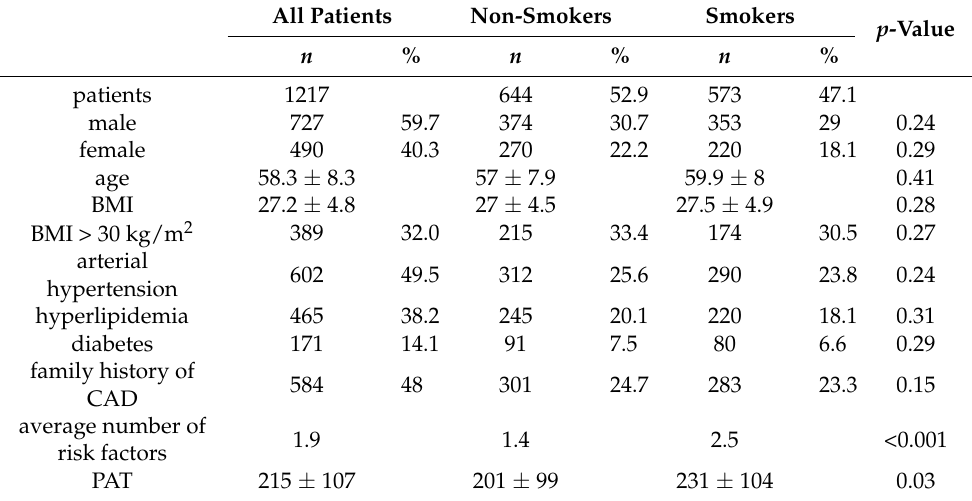
Table 1. Baseline characteristics of 1217 patient included in the